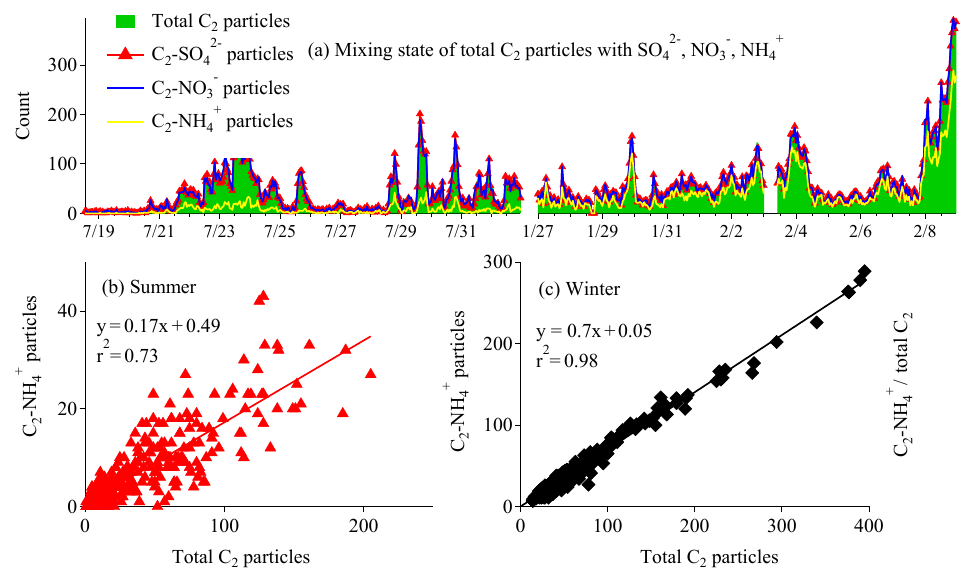
Figure 3. (a) Mixing state of oxalic acid with sulfate, nitrate and ammonium in oxalic-acid-containing particles; (b) linear correlation between NH + -containing oxalic acid particles and the total oxalic acid particles in summer; (c) linear correlation between NH + 4 oxalic acid particles and the total oxalic acid particles in winter. Abbreviations: C 2 -NH + and C 2 -SO 2 − and C 2 -NO − follow the same 4 3